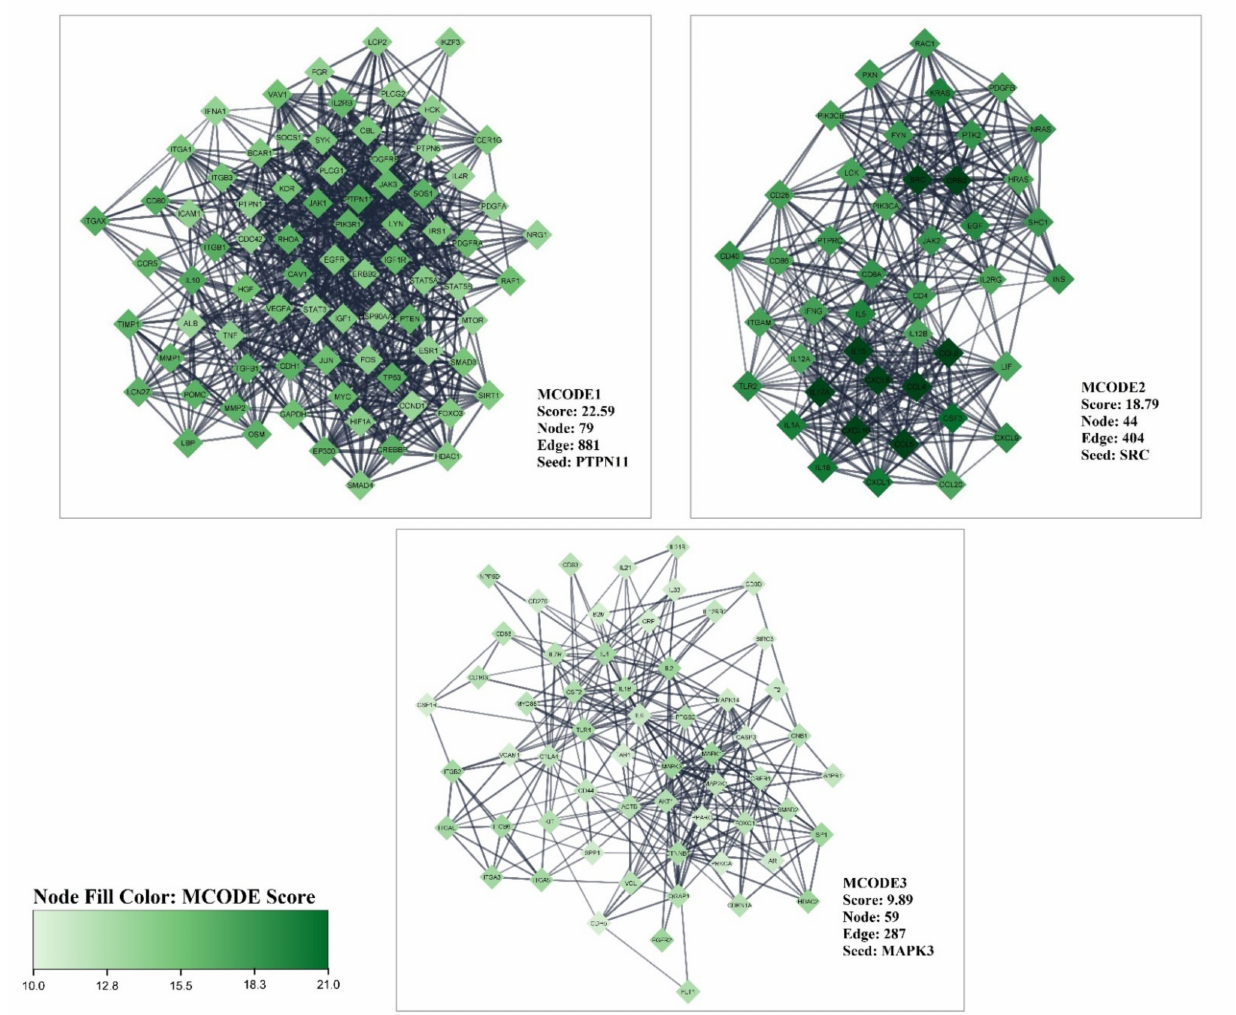
Figure 4. The three top score clusters of genes/proteins related to liver cirrhosis based on MCODE